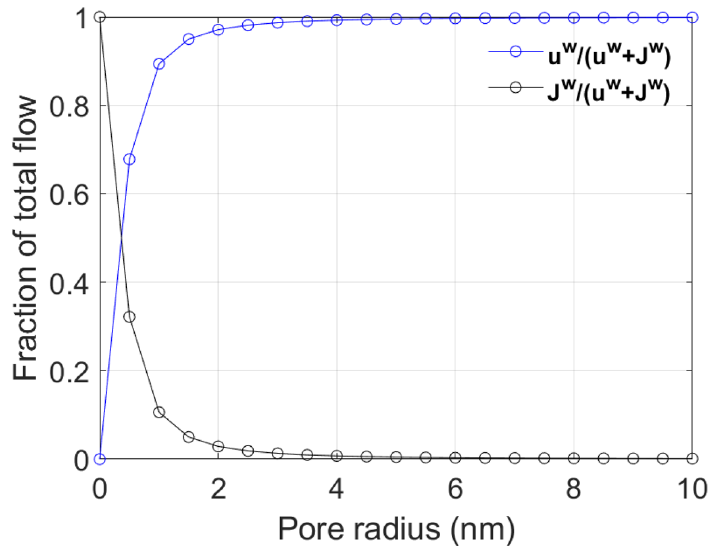
Figure 10. Fraction of total flow due to capillarity and